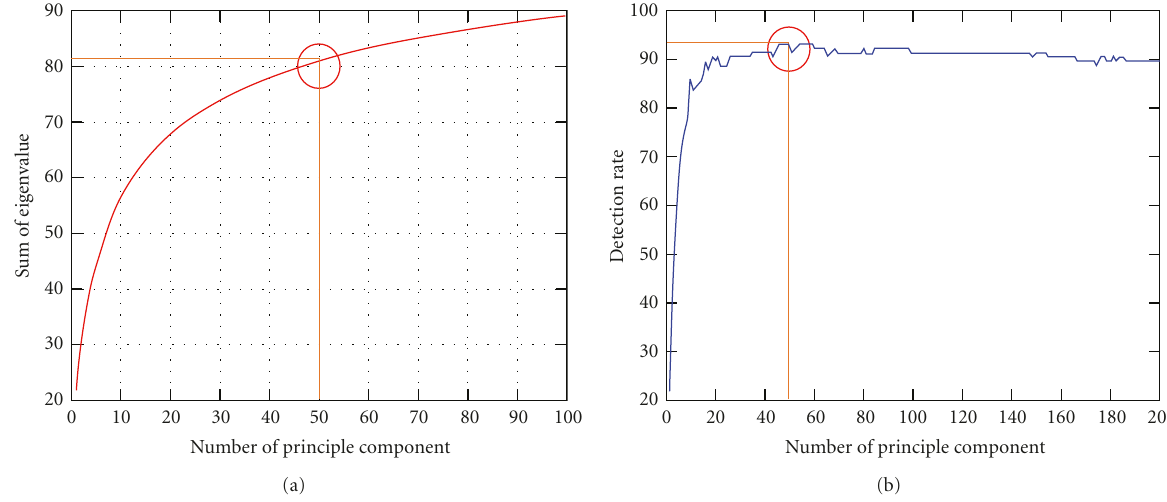
Figure 11: The pattern information for the specific dimensions of image subspace (a) the sum of eigenvalues and (b) the detection rate with respect to the number of eigenvectors.